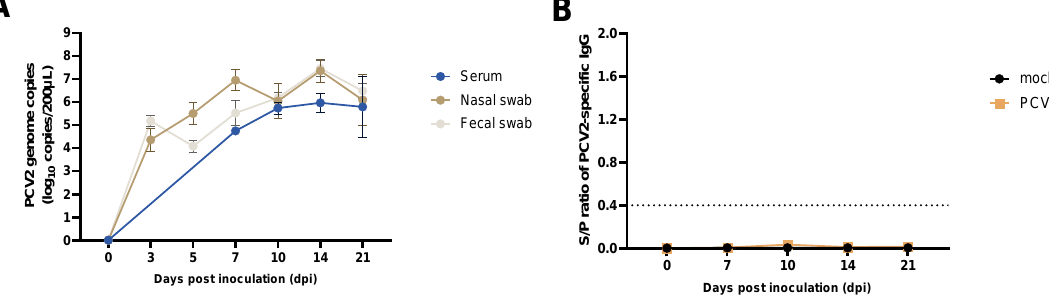
Figure 3. PCV2 genome copies and PCV2-specific IgG levels in the experimental infection/pathogenicity study (Experiment 1). Quantitative PCR analysis of PCV2 genome copies in the PCV2d infection group ( A ), and the levels of PCV2-specific antibodies in the mock and PCV2d infection groups ( B ). All data are presented as group means ± SEM.